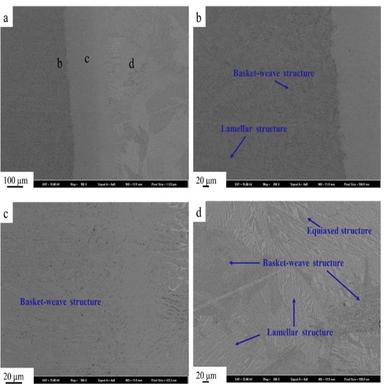
SEM images showing the morphology and the variation of microstructure in the overlap zone for the 2.0 mm overlap specimen: (a) the interfacial zone of 2.0 mm overlap specimen; (b), (c) and (d) are all magnified images shown in a).